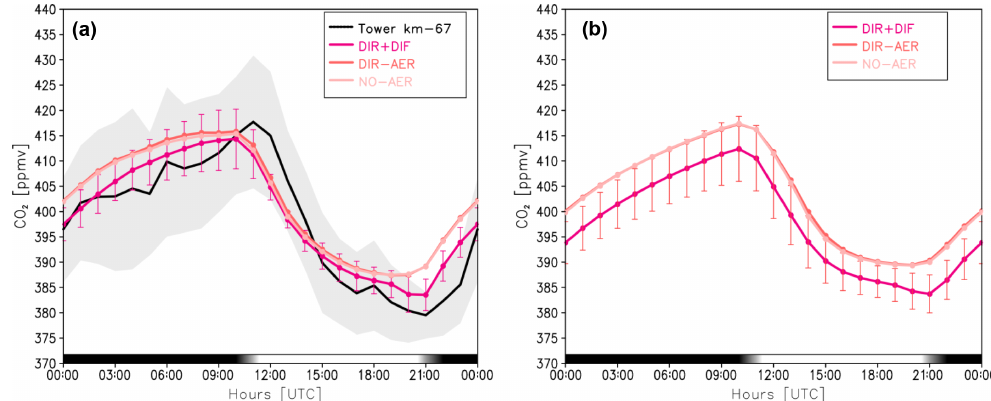
Figure 9. (a) Mean diurnal cycle of the CO 2 (ppmv) mixing ratio (black line) during September 2010 in Tapajós forest tower at 39.6m (2.85 ◦ S, 55.04 ◦ W; slightly southward of Santarém; location indicated in Fig. 2). The gray shaded area indicates the standard deviation of mean values observed. (b) Mean diurnal cycle of the CO 2 (ppmv) mixing ratio from the model during the same period in the LBAR (red line in Fig. 2). In both plots, model results are at the 39.3m model level for the three simulations NO-AER (light pink), DIR-AER (pink), and DIR+DIF (red). The red error bars on the model curves refer to the standard deviation of the mean model values.